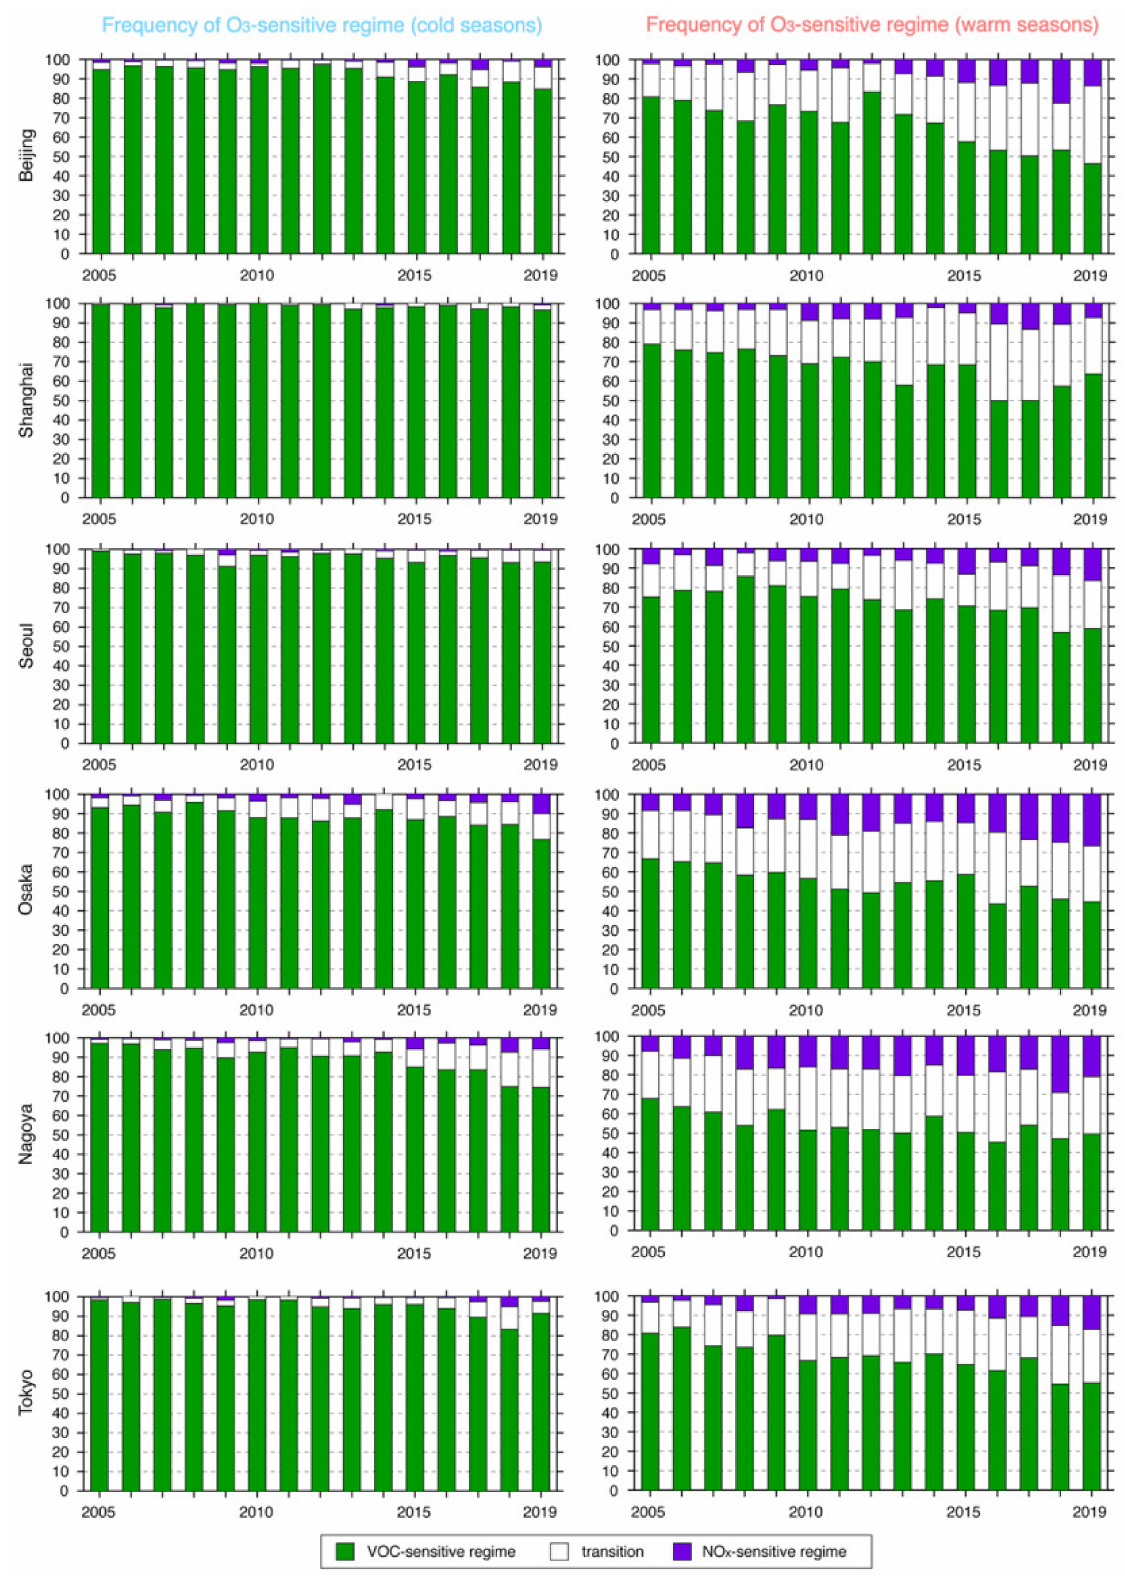
Figure 5. Frequency of occurrence of the O 3 -sensitive regime for the (green) VOC-sensitive regime, (white) transitional regime, and (purple) NO x -sensitive regime over Beijing and Shanghai in China, Seoul in the Republic of Korea, and Osaka, Nagoya, and Tokyo in Japan during ( left ) cold seasons and ( right ) warm